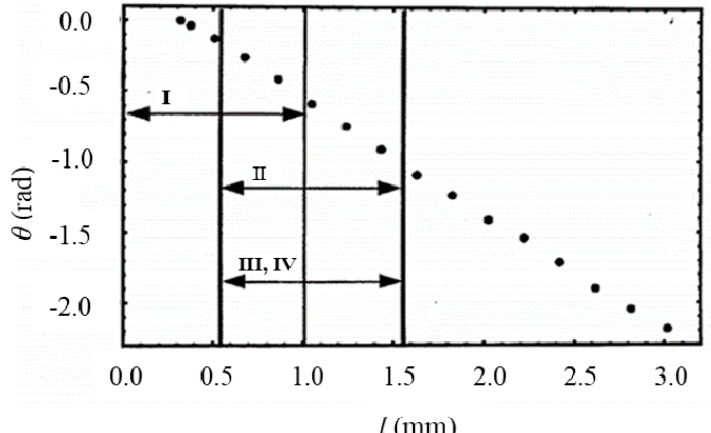
Figure 6. Contour plot for deriving the thermal diffusivity using the optimal heating-detection distance: ( a ) distance for analysis, ( b ) corrective coefficient. I, II, III, and IV are referred to Figure7.